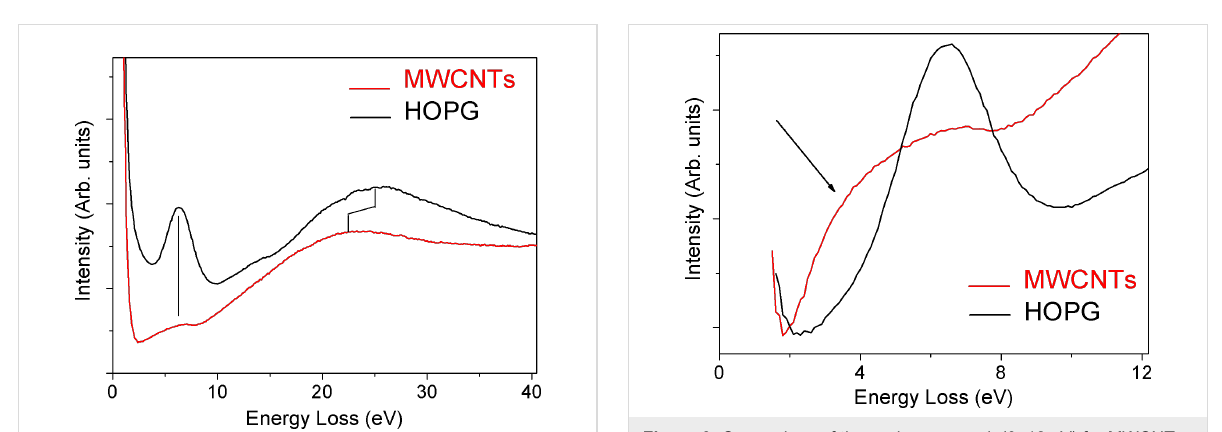
Figure 6: Comparison of the π -plasmon peak (0–12 eV) for MWCNTs (red curve) and HOPG (black curve). It is worth noting that in the case of MWCNTs we find electronic structures also at 2.0–4.5 eV, while in HOPG they are completely absent. These features contribute to the π - plasmon, giving rise to a very broad peak. Transitions between Van Hove singularities are thought to be responsible for these additional features.